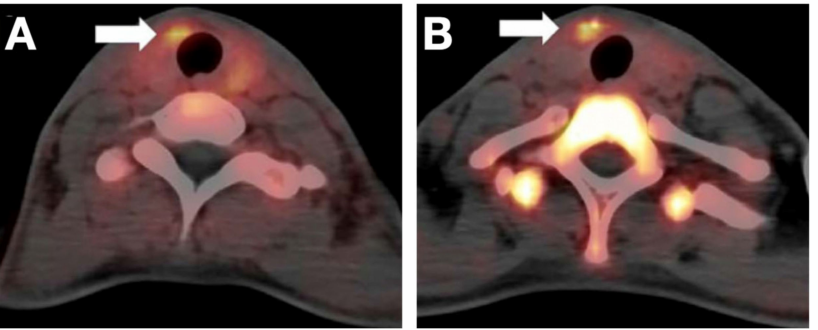
Figure 4. Example of a PTC revealed by [ 18 F]FGln at 10 min ( A ) and 60 min ( B ) post-injection, respectively. The arrows indicate the malignant lesion. Reproduced with permission from [62], copyright 2020 Springer Nature